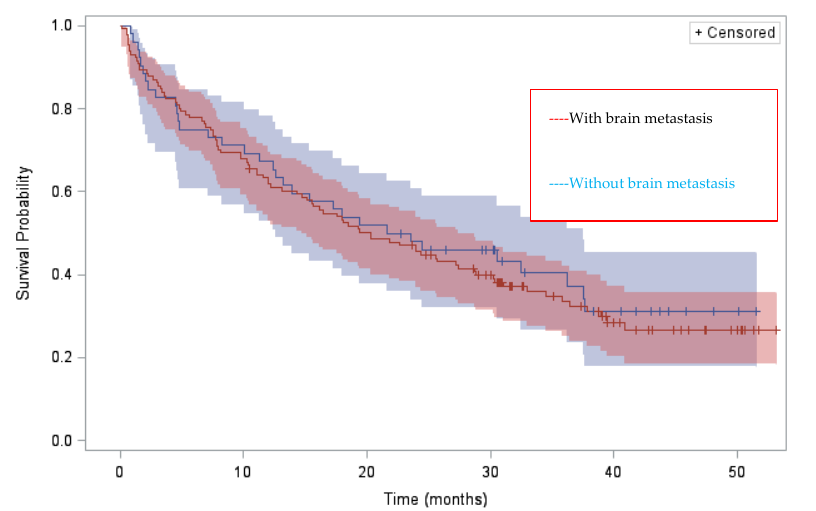
Figure 2. Median overall survival from brigatinib initiation of patients with and without brain metastases. At the time of the analysis, 112/183 patients (60.9%) had progressed on brigatinib. Progression involved known metastases for 110/112 (98.2%) patients (known brain lesions Table 4. Outcome parameters for the 183 brigatinib-treated patients. for 45) and new lesions for 47/112 (42%), 23 of which were cerebral.